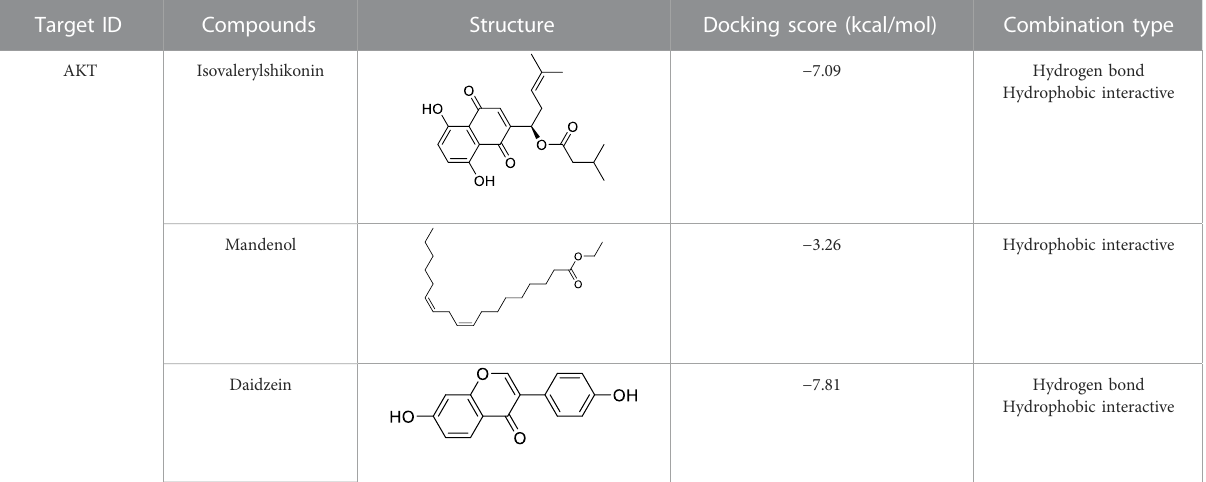
TABLE 4 Docking results for AKT with